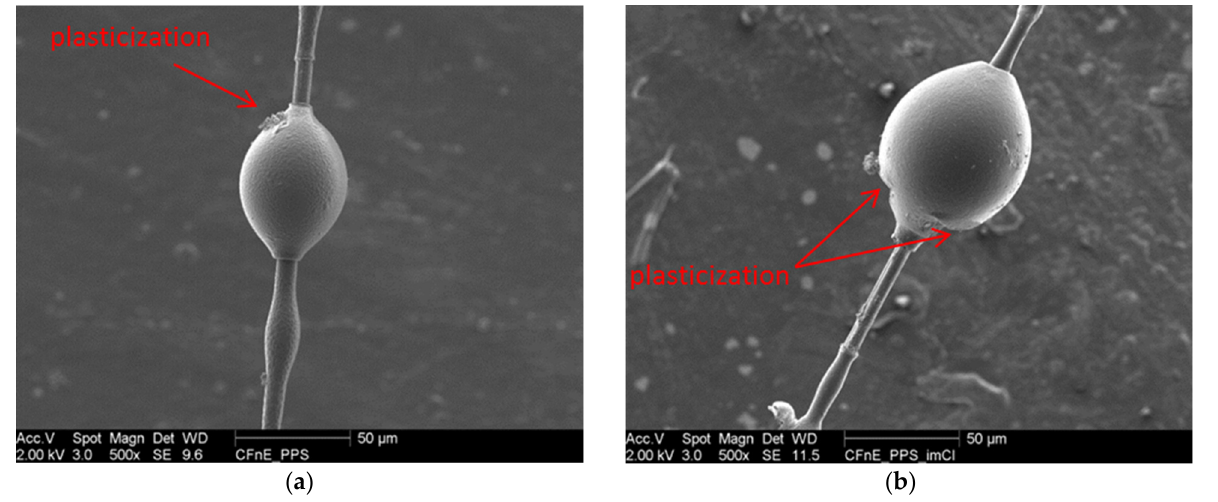
Figure 8. PPS ( a ) and PPS_ImCl ( b ) post-mortem droplets.